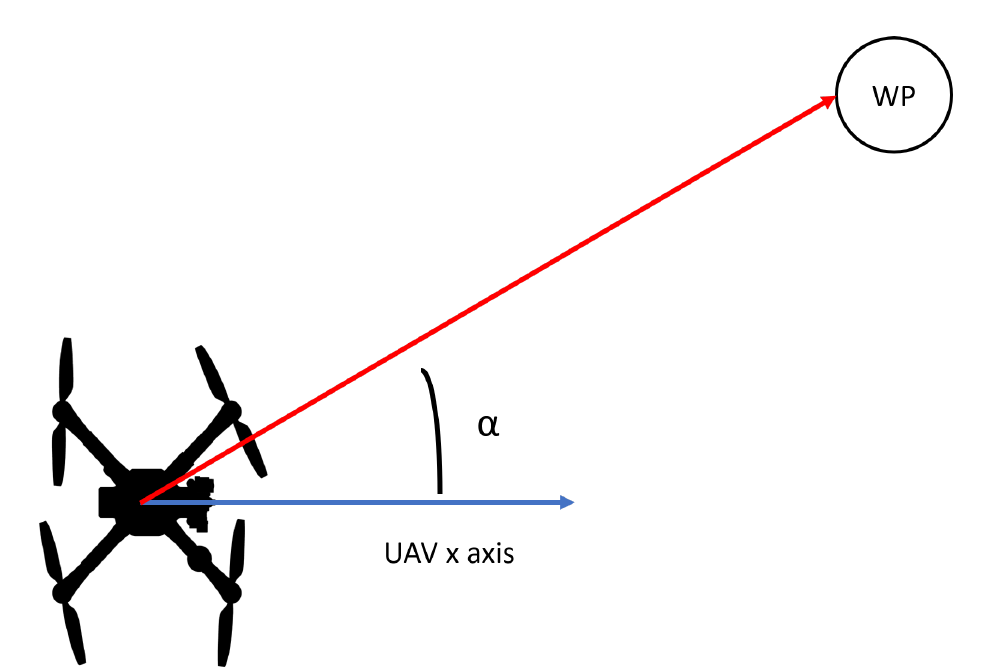
Figure 17. Orientation calculation scheme to allow autonomous navigation with the UAV focused on the target to be